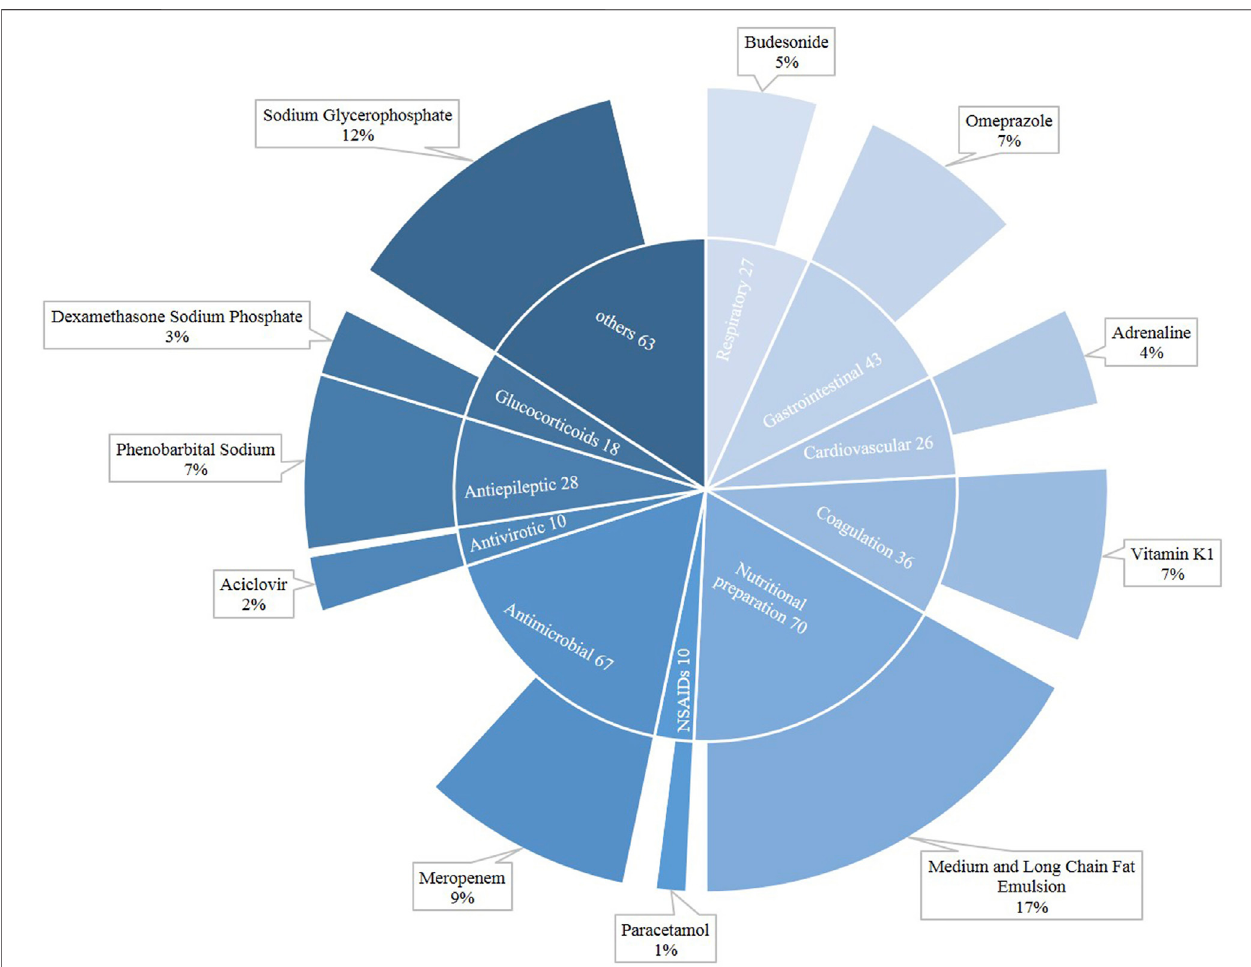
FIGURE 2 | Drug categories for neonatal drug-induced liver injury.